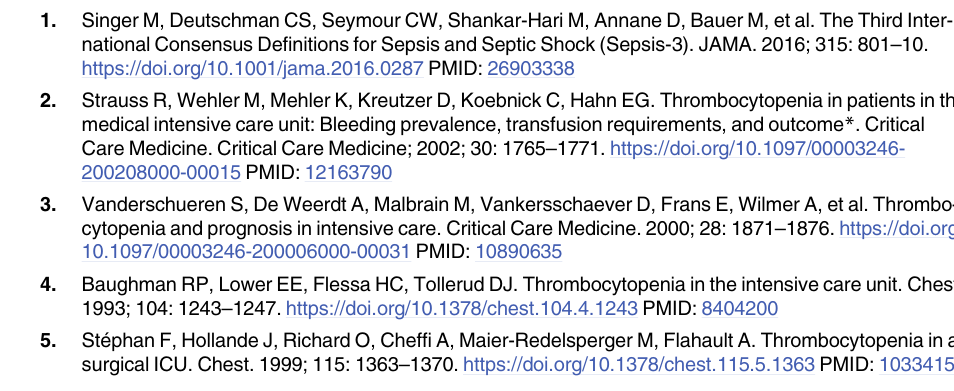
S1 Table. Spearman rank correlation between platelet count and MPV. S2 Table. Correlation coefficients between SOFA score at admission and MPV. S1 Fig. Comparison of serum lactic acid kinetics according to 90-day survival. S2 Fig. Comparison of blood pH kinetics according to 90-day